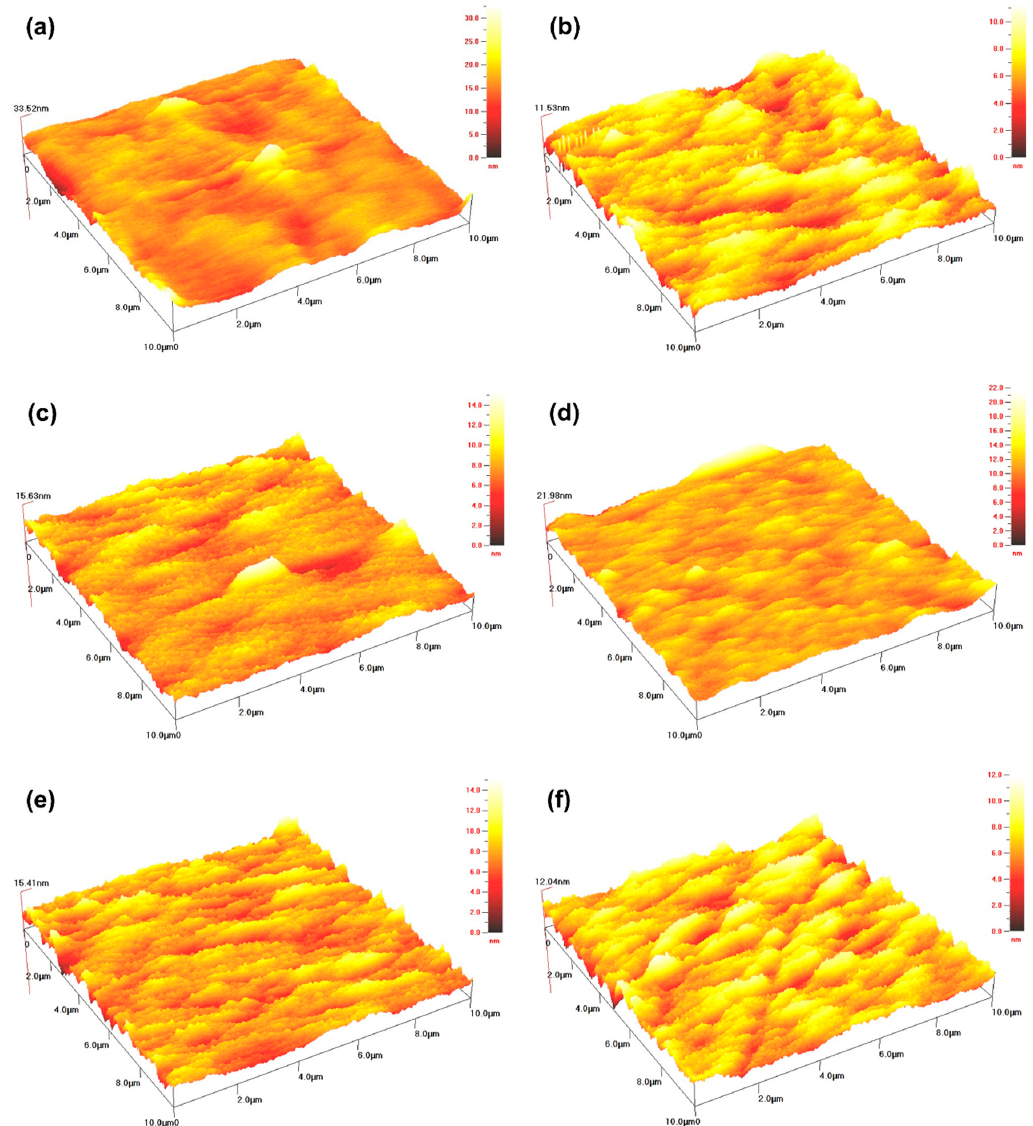
Figure 4. Atomic force microscopy (AFM) analysis images for the morphology of chitosan coating with TiO 2 nanoparticles 10 μ m × 10 μ m; ( a ) 0; ( b ) 0.01%; ( c ) 0.03%; ( d ) 0.05%; ( e ) 0.07%; ( f ) 0.09%.